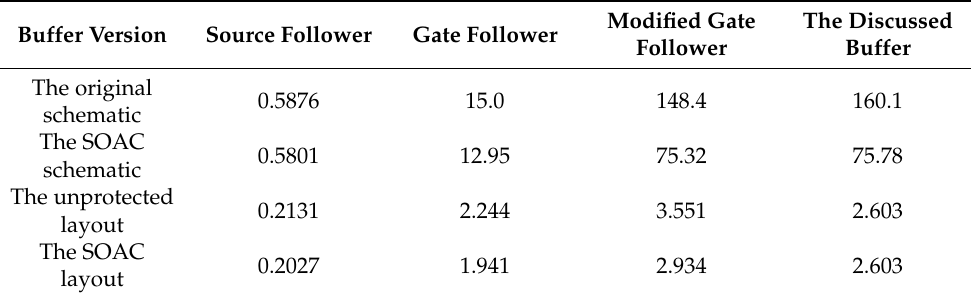
Table 8. Comparison of input impedance [M Ω ] for different implementation stages of the source follower, gate followers, and discussed